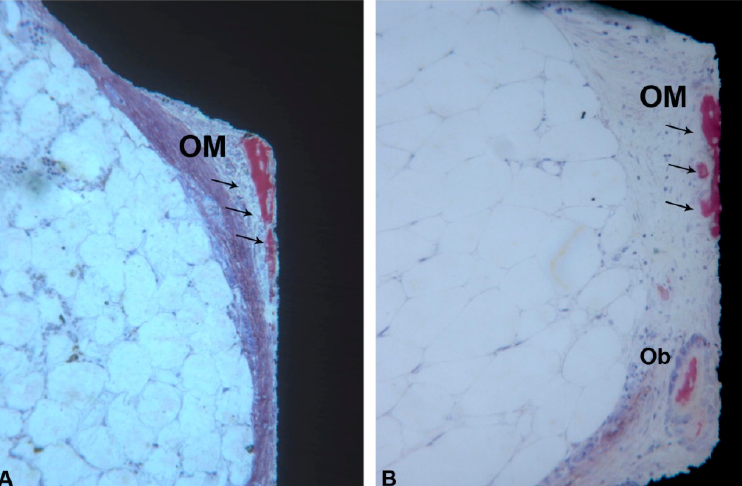
Figure 11. ( A - B ) Marrow portion. In the apical portion, a layer of osteogenic matrix (OM) inside the concavities was observed close to the implant surface and it was clearly delimited from the bone marrow by a dense band ( black arrows ) (Acid fuchsin-Toluidine blue 18X). Table 3. Tissues quality at the level of the implant surface in the marrow